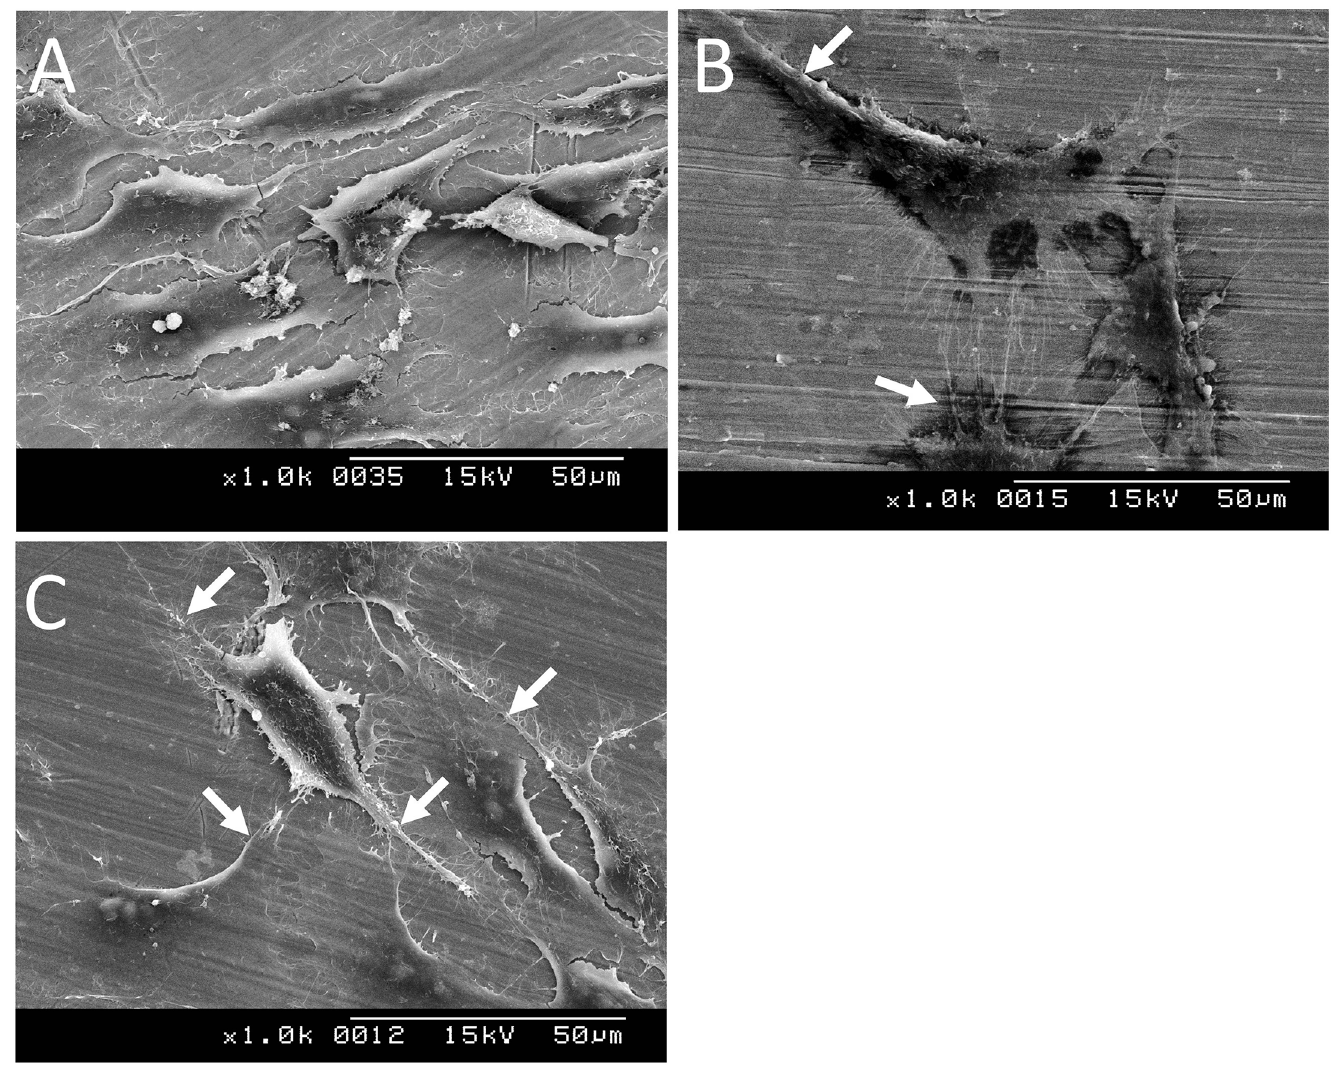
Fig 6. Scanning electron microscopy images of MG-63 cells cultured on original specimen (a), Ar-GDP (b), and GDP-fib (c) titanium discs after 24 h. Cells showed morphological alternation from spindle to more-stellar shapes, and extensive process ( white arrows